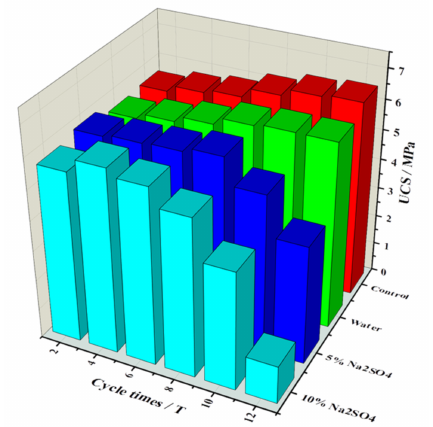
Figure 8. Histogram for UCS under different erosion conditions.